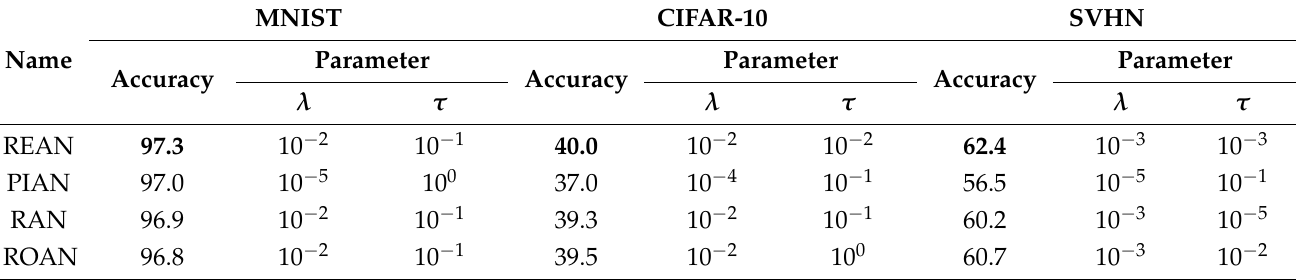
Table 1. Comparative experiment results on MNIST, CIFAR-10 and SVHN datasets.